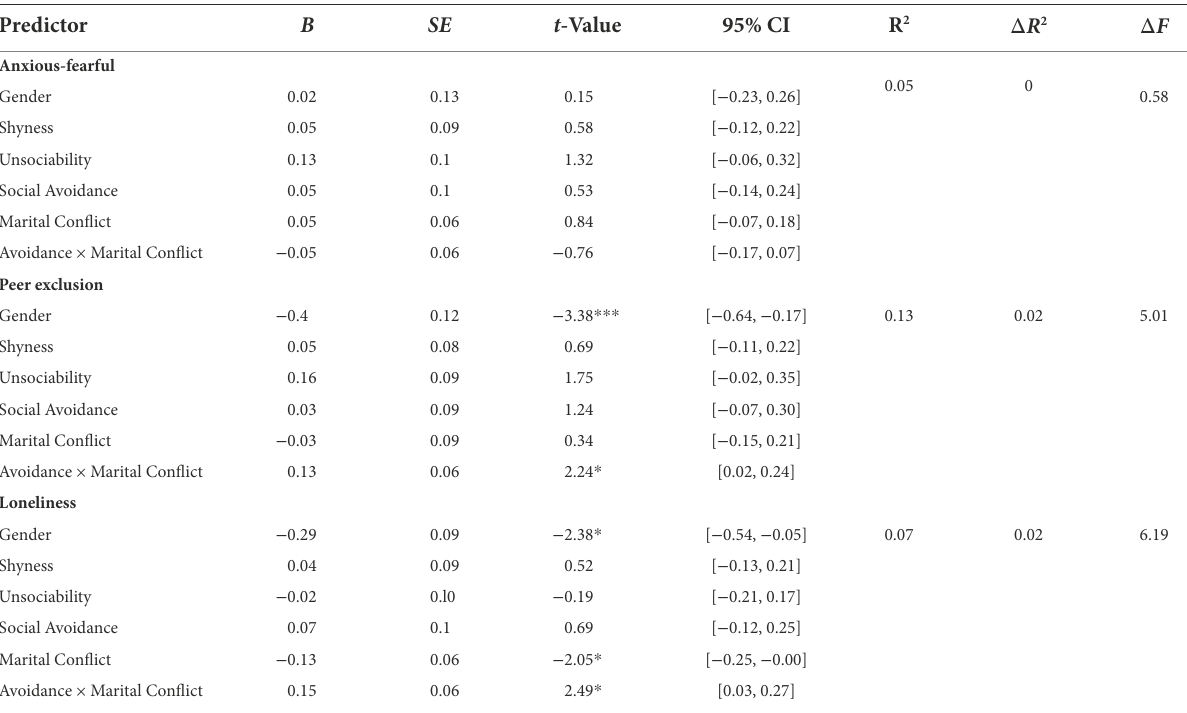
TABLE 3 Effects of social avoidance, marital conflict (controlling for gender) in relation to indices of social